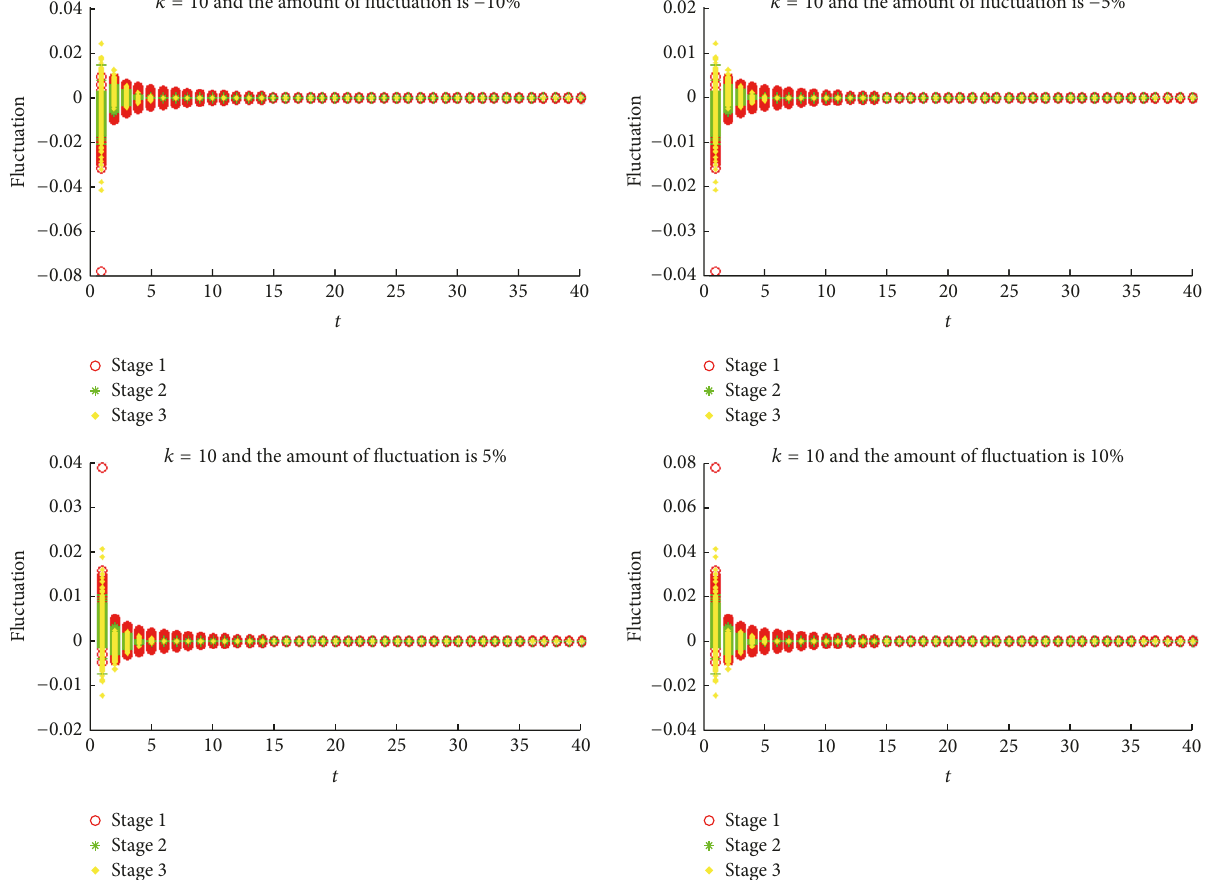
Figure 5: Dynamic evolution of fluctuation in the network when 𝐾 = 10